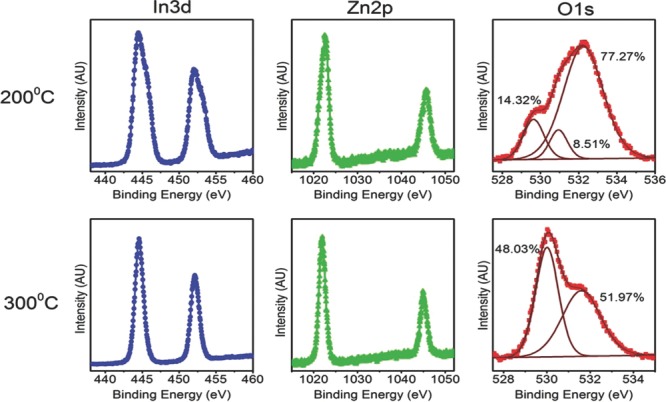
XPS data for IZO (In2O3:ZnO = 6:4) films annealed
in air for 4 h at 200 °C (top) and 300 °C (bottom). Left: In
3d core level. Middle: Zn 2p core level.
Right: Oxygen 1s core level resolved into Gaussians
representing different oxygen binding environments: 1) OH species at a binding
energy of ≈532 eV; 2) fully coordinated oxygen at ≈530 eV; and 3)
oxygen vacancies at ≈531 eV (only resolved for the 200 °C
sample). The XPS data were taken on the surface of the films.